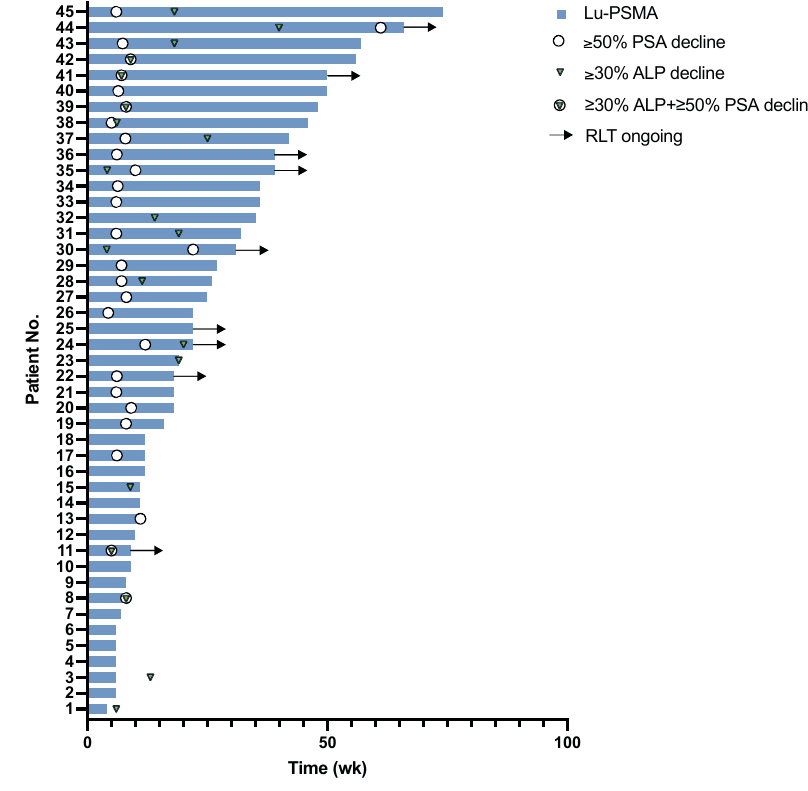
Figure 2. Swimmer plot with response events throughout RLT.